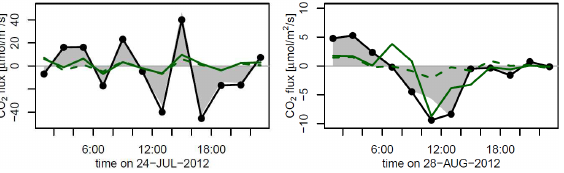
1 Figure 8 Exemplarily in-situ comparison between the measurements at the tall tower (grey area 2 Fig. 8. Example in situ comparison between the measurements at represents the storage flux, black line is storage + turbulent flux) and the forest flux tower (storage flux 3 the tall tower (the grey area represents the storage flux and the black as dark green dashed line, Eddy covariance + storage flux as dark green line); left: during strong forest 4 fires near the site on 24 th July, 2012; right: during late summer on 28 th August, 2012. 5 line is storage+turbulent flux) and the forest flux tower (storage flux as the dark green dashed line, eddy covariance+storage flux as the dark green line): left: during strong forest fires near the site on 24 July 2012; right: during late summer on 28 August 2012.